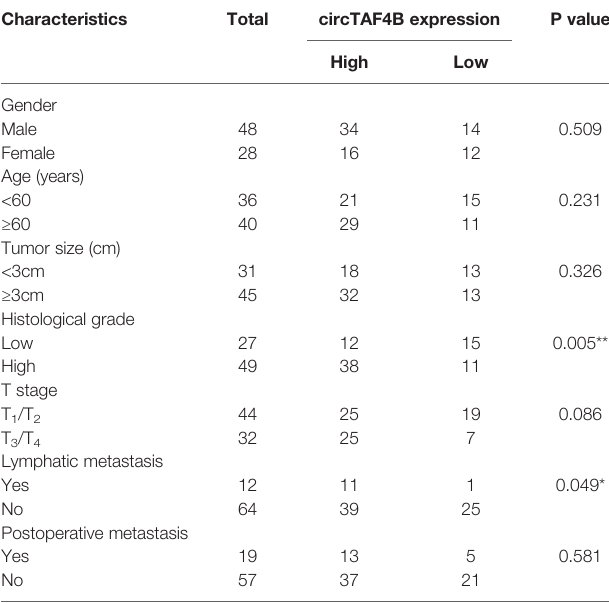
TABLE 1 | Correlation between circTAF4B expression and clinical characteristics in 76 BCa